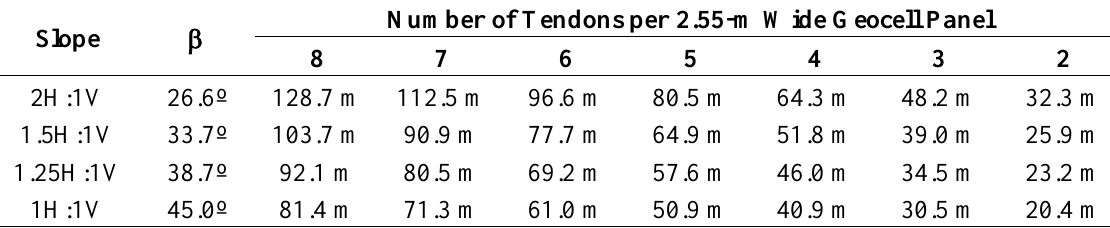
Table 4. Maximum design slope lengths for FS = 1.50 (ice design